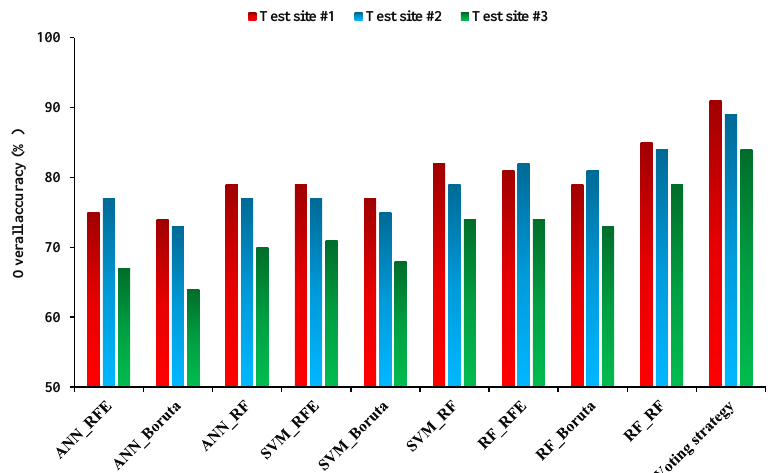
Figure 7. Overall accuracy assessment results for land crop/cover maps in test sites 1, 2, and 3.